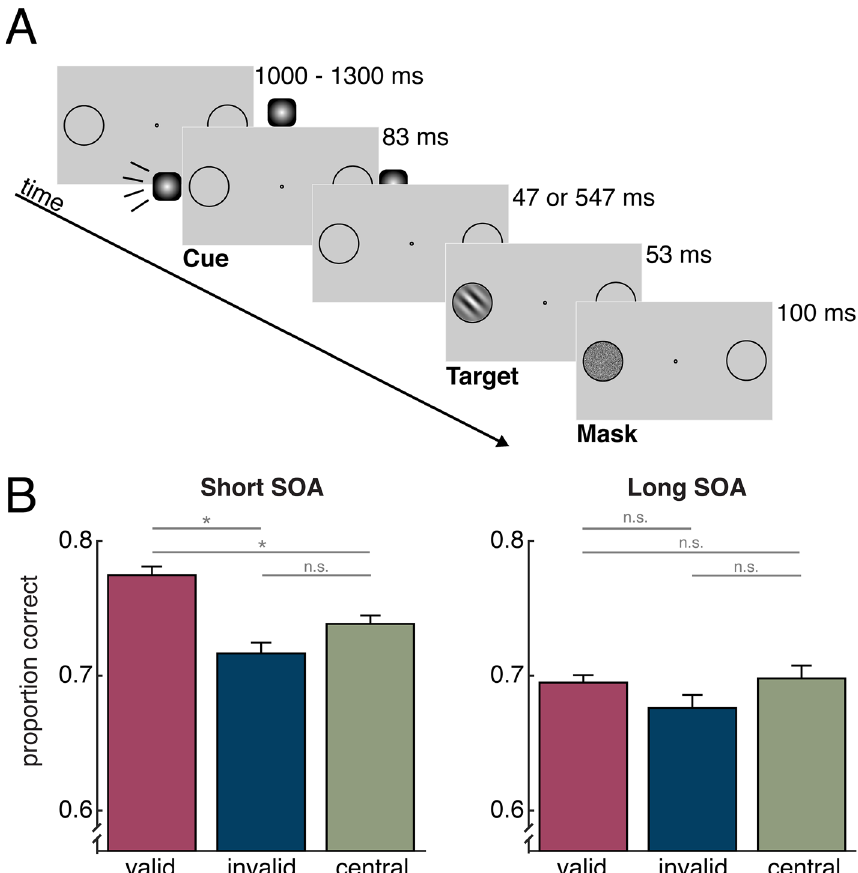
Figure 1. Example trial and performance. ( A ) Participants discriminated the direction of rotation (clockwise or counterclockwise) of a masked Gabor patch target. Prior to the appearance of the target, participants were presented with an auditory cue that was played randomly either 130 ms or 630 ms prior to the target. This sound was a pink noise burst played either in stereo from peripheral speakers such that it appeared to emanate from either the left or right of the screen, or from a speaker at the top center of the screen such that it appeared to emanate from the center of the screen. On one third of the trials, no visual target was presented. ( B ) Target discrimination accuracy, plotted as a function of cue condition for each of the cue-target SOAs. Error bars represent ± 1 standard error of the mean. Asterisks indicate a significant (p < .05) difference between